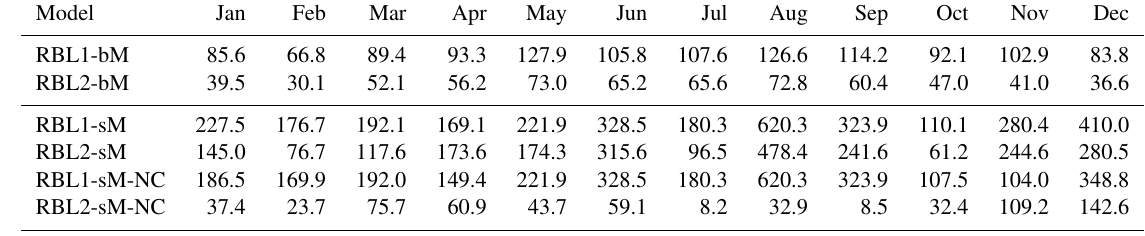
Table 5. Comparison minimum objective function values for different RBL models using Bochum gauge data.